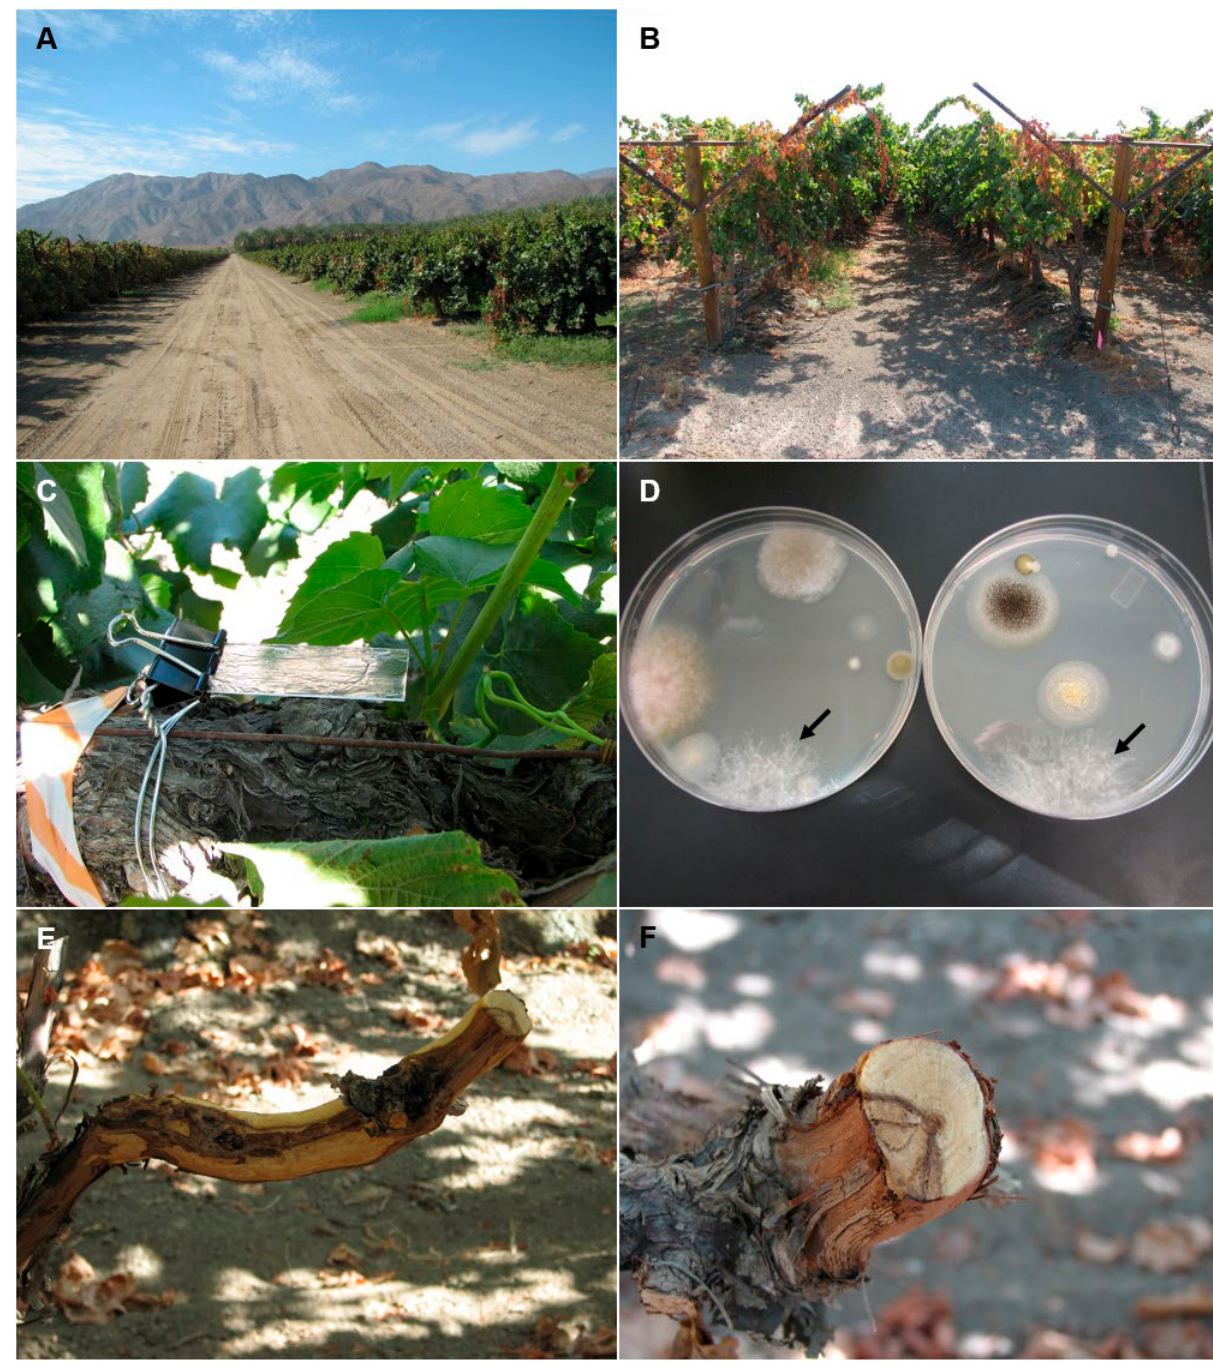
Figure 1. Spore trap study. A and B . Cv. Mid-Night Beauty® vineyard where the study was conducted in the Coachella Valley in southern California. C. Microscope glass spore trap coated with petroleum jelly and placed on the cordon of a grapevine. D. Petri dishes show- ing fungal colonies obtained from spore traps. Black arrows indicate characteristic Diatrypella -like colonies. E and F. Wedge-shape cankers observed and collected from symptomatic grapevines from the studied